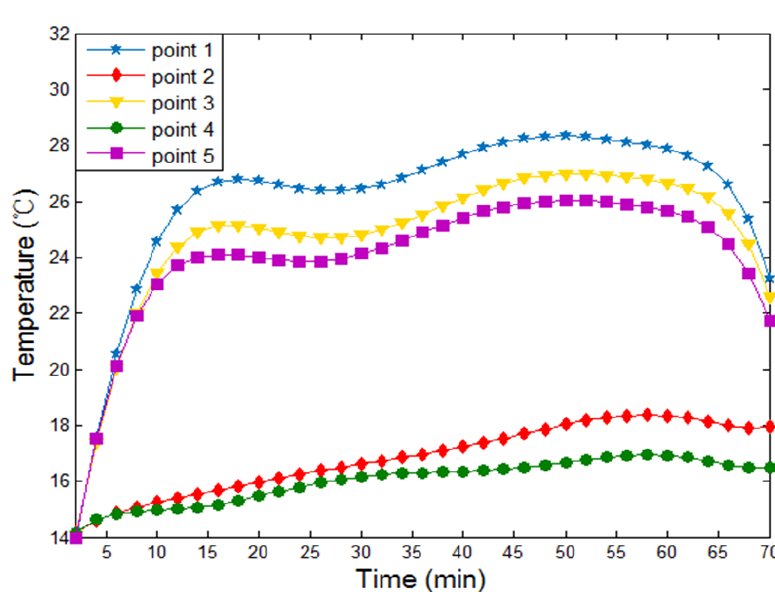
Figure 15. Temperature of each point in Experiment 4.